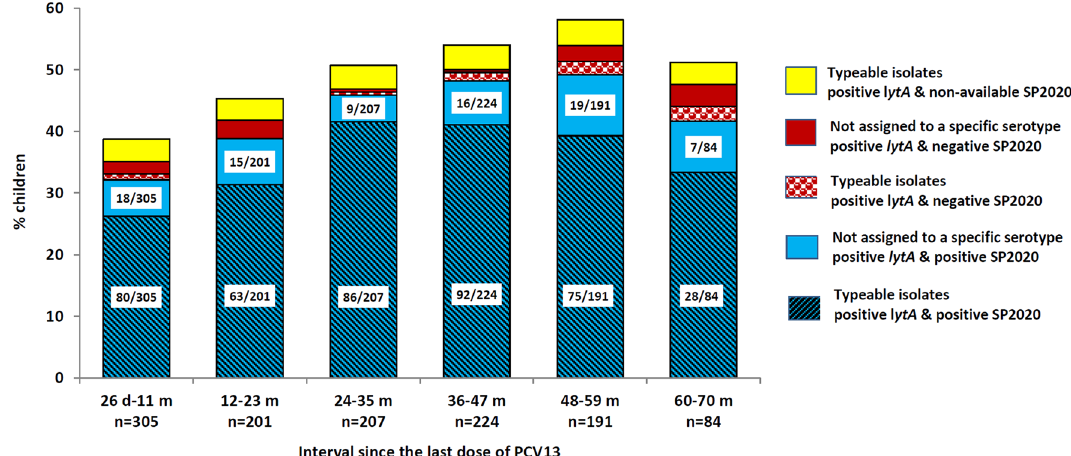
Figure 6. lytA and SP2020 gene positivity status of samples, according to time elapsed since the 4th (booster) dose (six interval durations spanning 26 days to 70